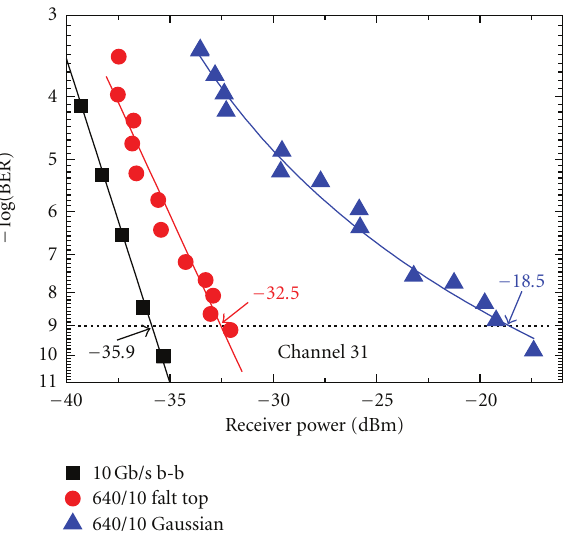
Figure 11: BER characteristics: back-to-back (squares), using flat- top pulses (circles), and using nonflat-top pulses (triangles). The demultiplexing results are from the same data